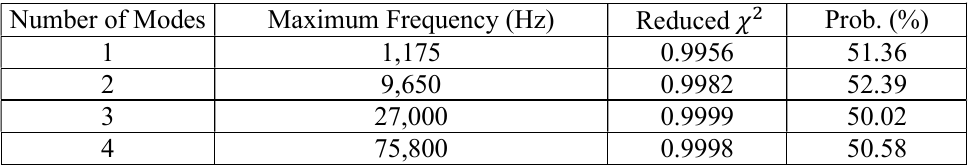
Table I. Maximum achievable frequency versus number of modes for the 286.6 ppm case. Number of Modes Maximum Frequency (Hz)